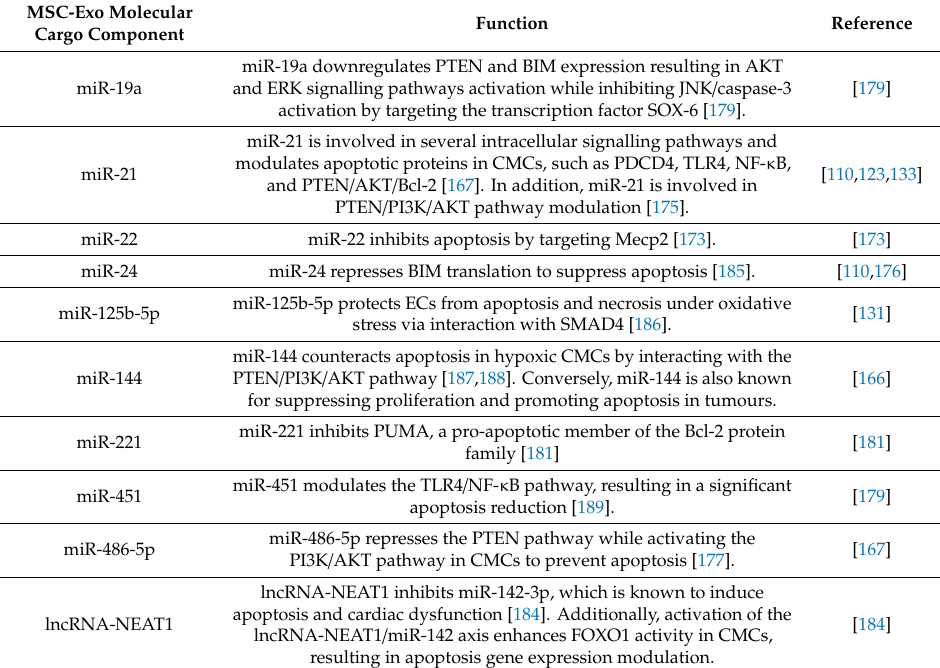
Table 2. List of components of the mesenchymal stem cell-derived exosomes (MSC-Exos) molecular cargo selected for their known potential to regulate the apoptosis process. MSC-Exo Molecular Cargo Component